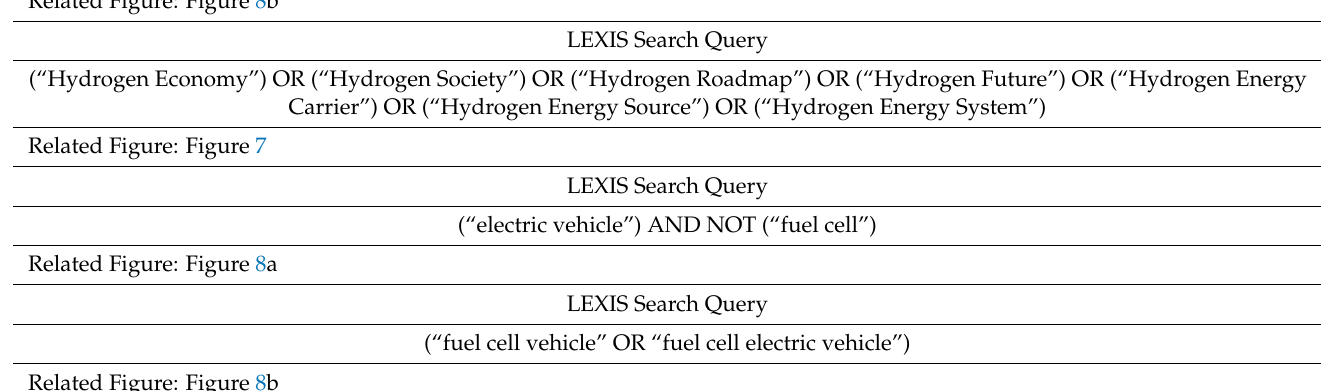
LEXIS Search Query